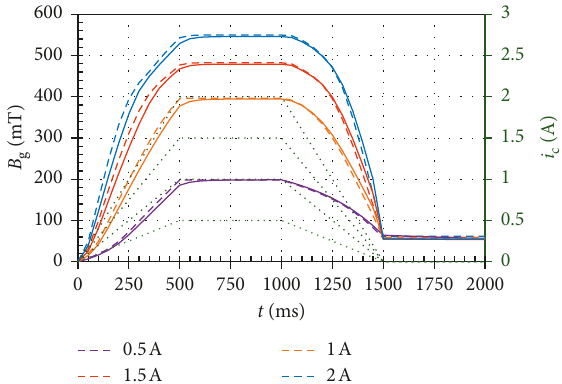
Figure 14: Time history of (gap) magnetic flux density: hysteresis ON (dashed line), hysteresis ON and eddy currents OFF (solid line), and electric current (dotted line).